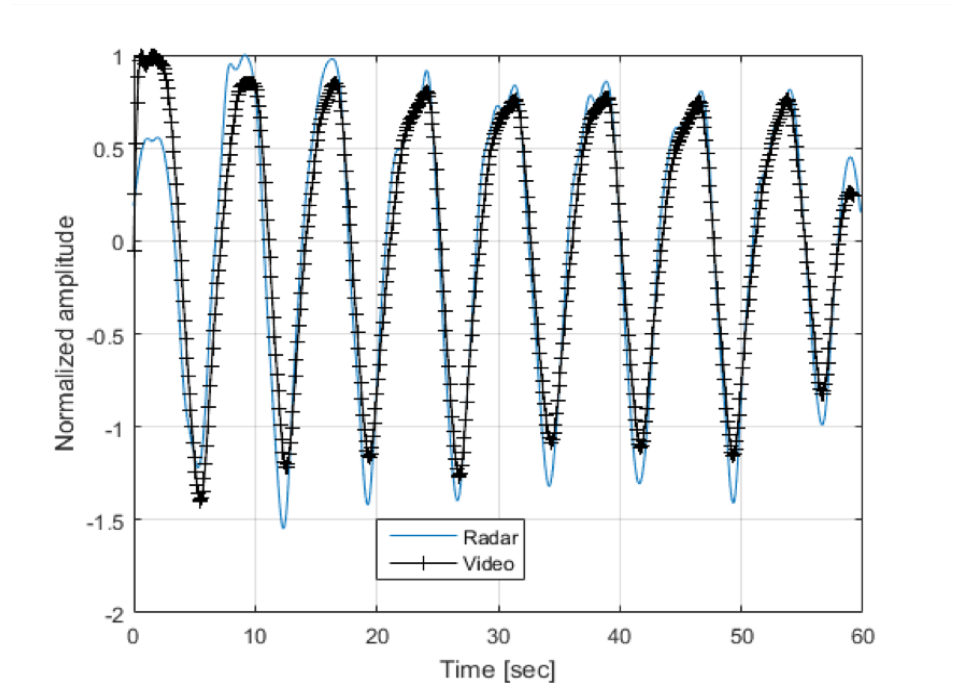
Figure 6. Radar and vision extracted breathing